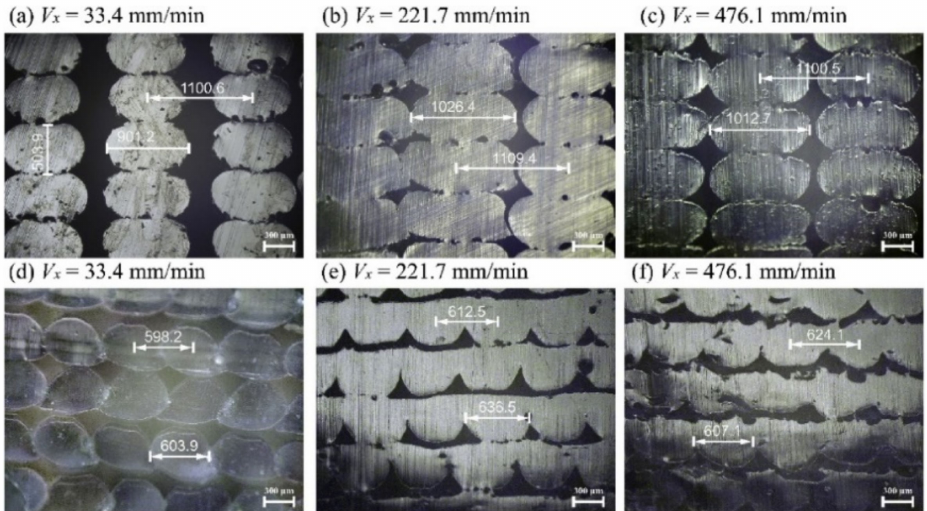
Figure 2. Cross section of PEEK samples at different printing speeds. ( a – c ) PEEK samples printed considering of extrusion control algorithm and ( d – f ) PEEK samples printed disregarding the swelling of molten polymer die (reprinted with permission from [87]).